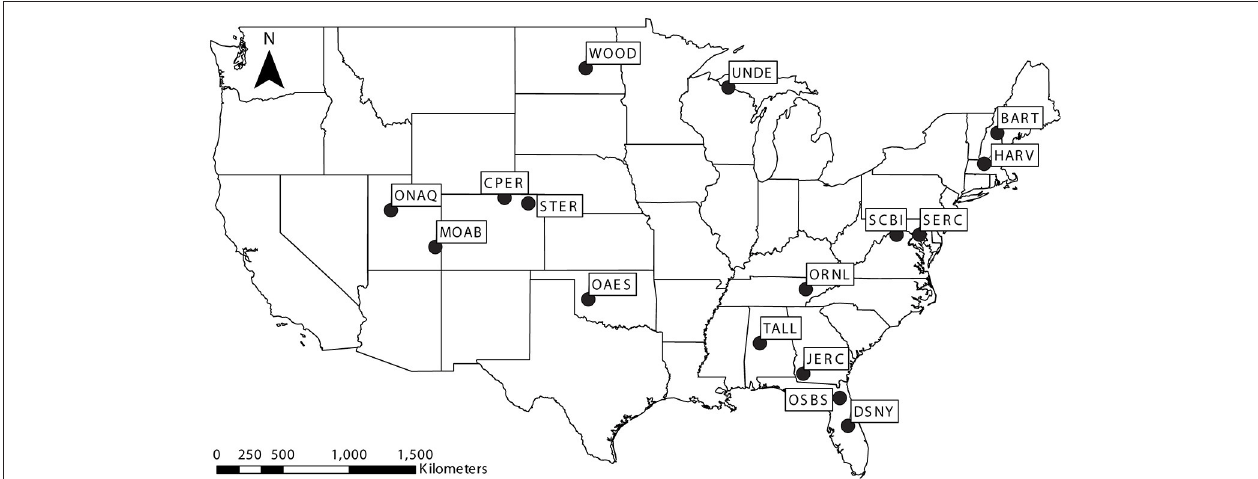
FIGURE 1 | Map of the United States showing study communities collected from established National Ecological Observatory Network sites: Bartlett Experimental Forest (BART), Central Plains Experimental Range (CPER), Disney Wilderness Preserve (DSNY), Harvard Forest (HARV), Jones Ecological Research Center (JERC), Moab (MOAB), Klemme Range Research Station (OAES), Onaqui-Ault (ONAQ), Oak Ridge National Laboratory (ORNL), Ordway-Swisher Biological Station (OSBS), Smithsonian Environmental Research Center (SERC), Smithsonian Conservation Biology Institute (SCBI), North Sterling (STER), Talladega National Forest (TALL), Woodworth (WOOD), and University of Notre Dame Environmental Research Center